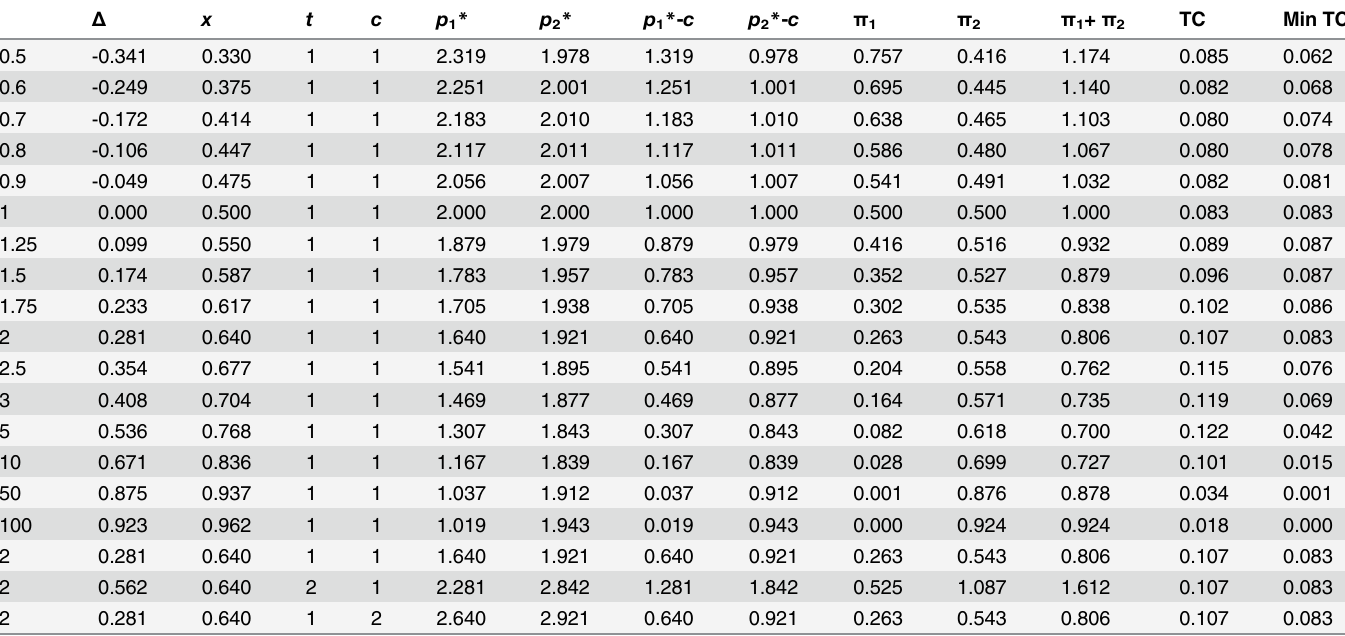
Table 1. Equilibrium for F ( b ) = b α and various values of α